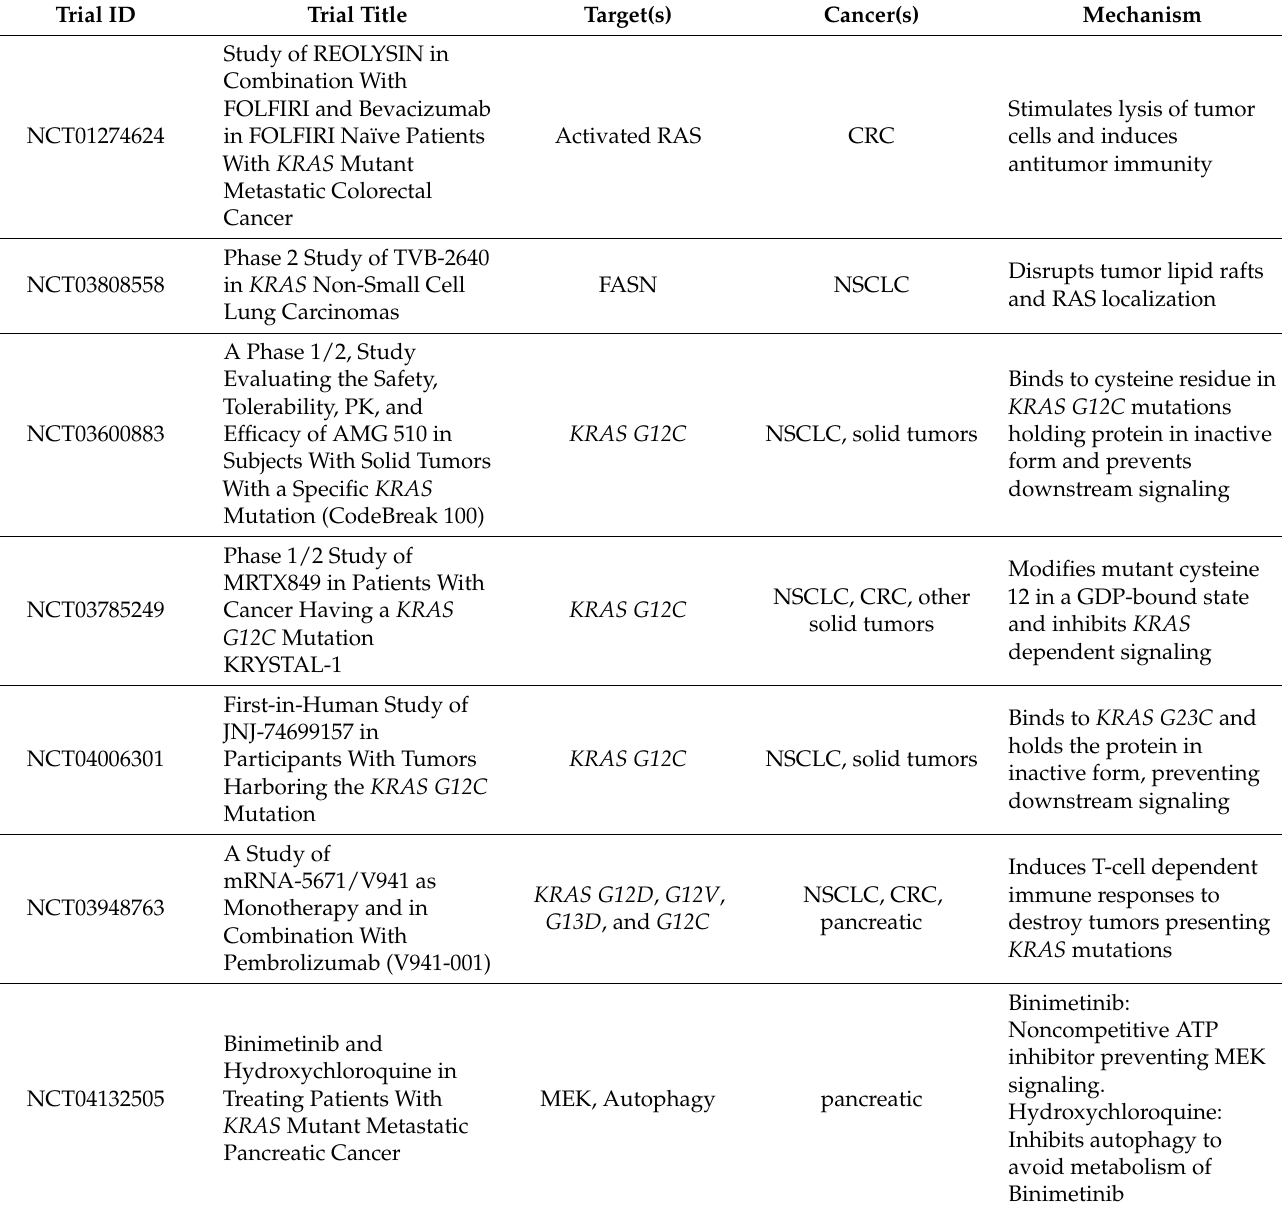
Table 1. Select recent clinical trials targeting KRAS and downstream signaling